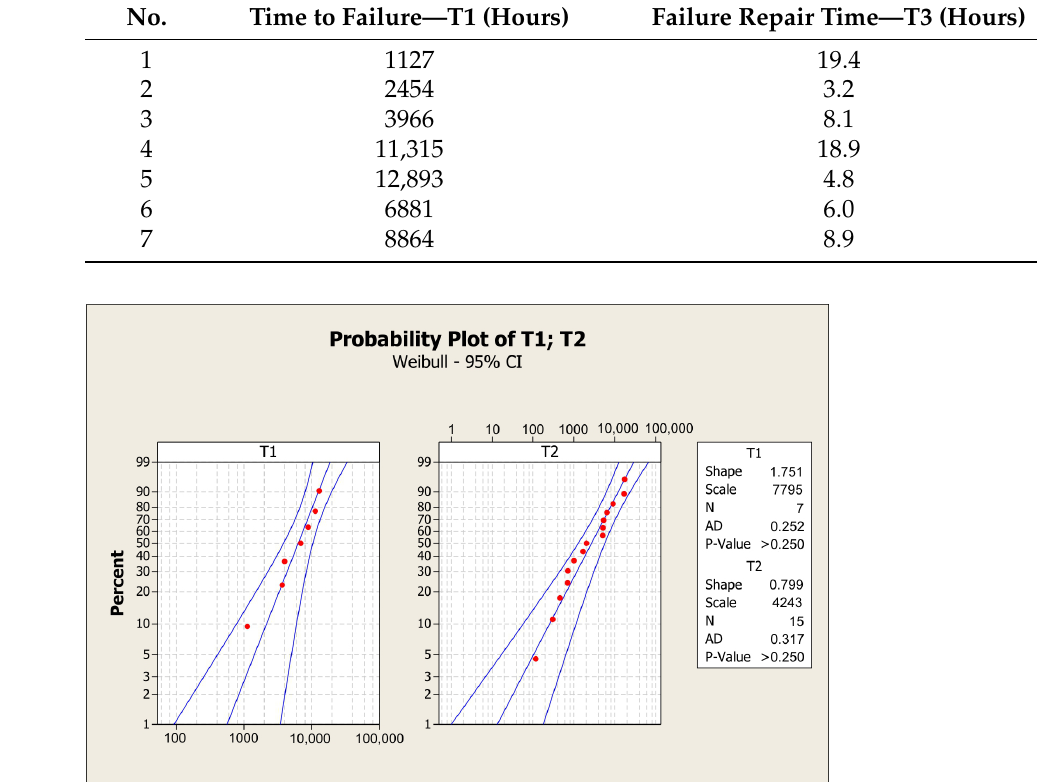
Table 1. Empirical data for the coal mill feeder used in the statistical analysis of failures and the time needed for their repair.